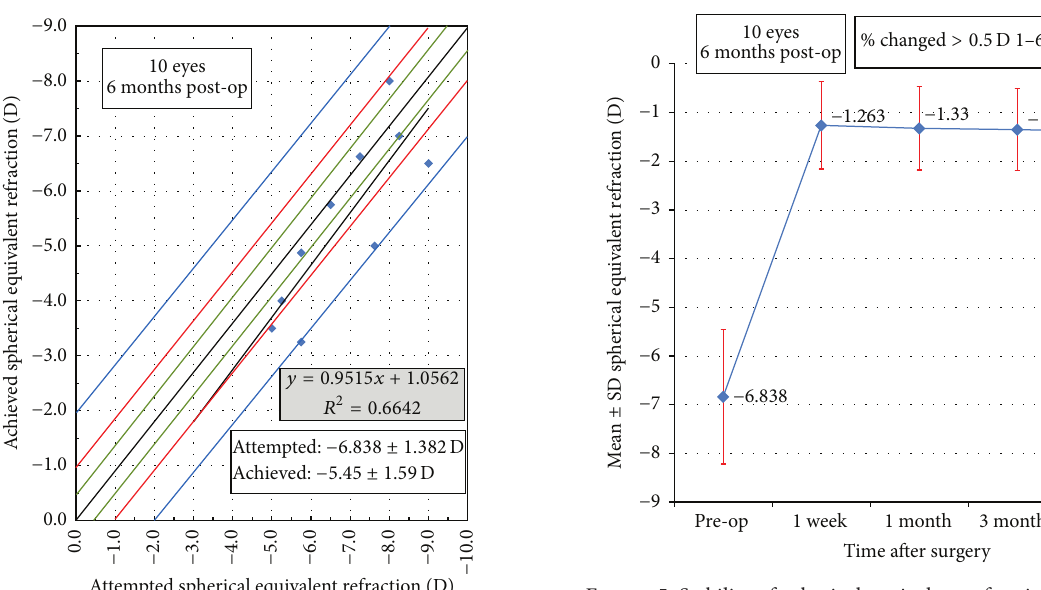
Figure 5: Stability of spherical equivalent refraction 6m postoper- atively.